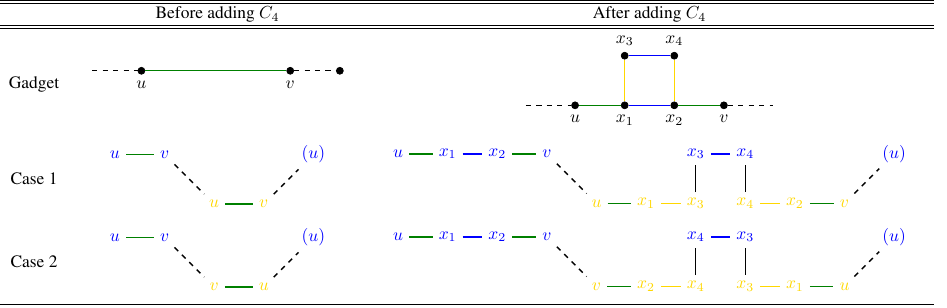
between u and v , we 4